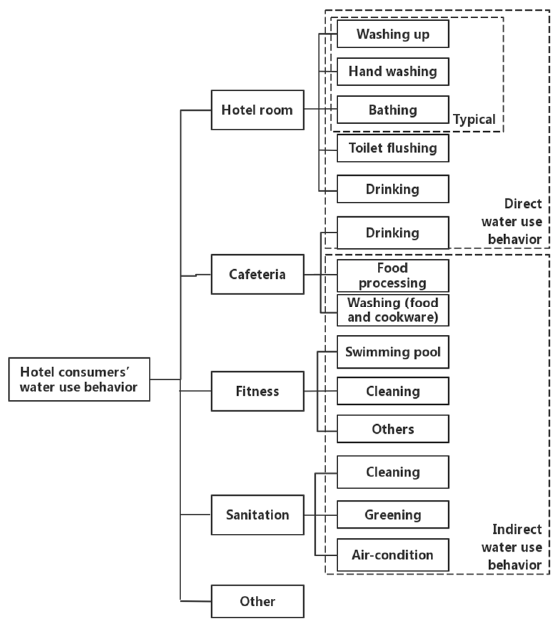
Figure 1. Structure of hotel consumers’ water-use behavior.